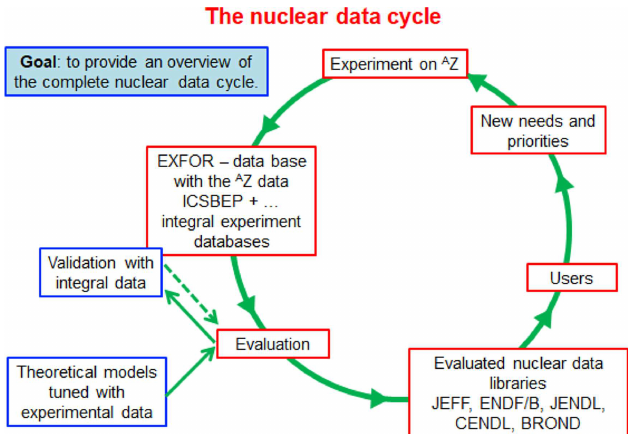
Fig. 5. The nuclear data cycle. All aspects were discussed in supervised online courses in small groups in the Nudatapath school organized by CIEMAT. (Courtesy: Daniel Cano-Ott,